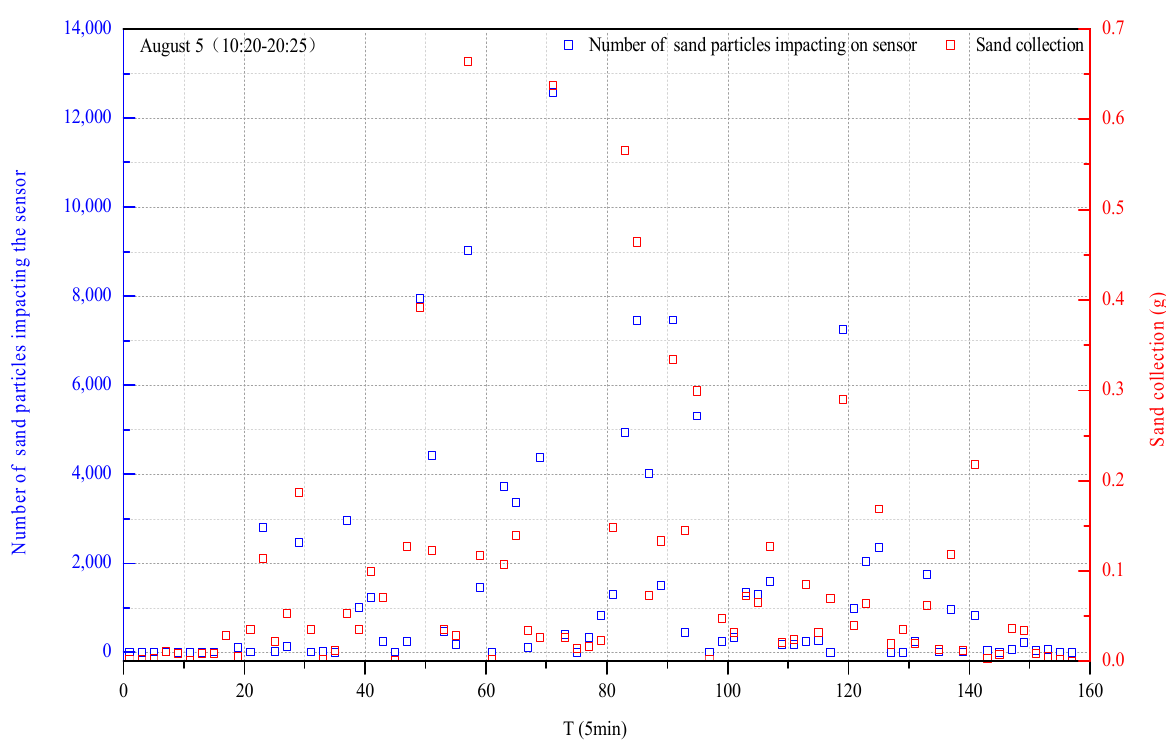
Int. J. Environ. Res. Public Health 2021 , 18 , x FOR PEER REVIEW Figure 4. Trends in the number of impact particles and the amount of sediment collected.